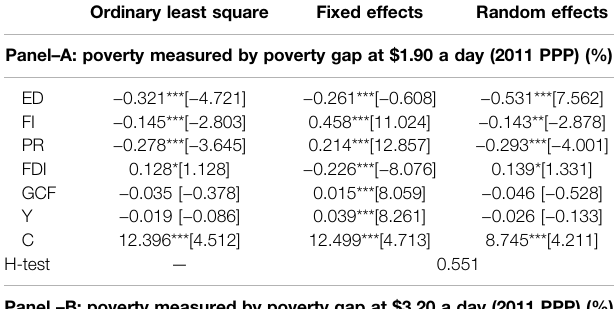
Panel-A: Padroni panel co-integration test